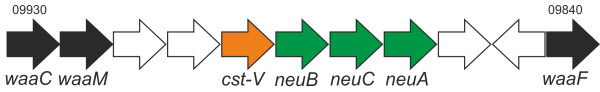
Lipooligosaccharide (LOS) locus C. coli strain 76339 located between waaC (BN865_09930) and waaF (BN865_09840). Conserved genes are indicated using black arrows. Putative glycosyltransferases are shown in white, sialyltransferase cst-V in orange and the sialic acid biosynthesis genes (neuBCA) in green.